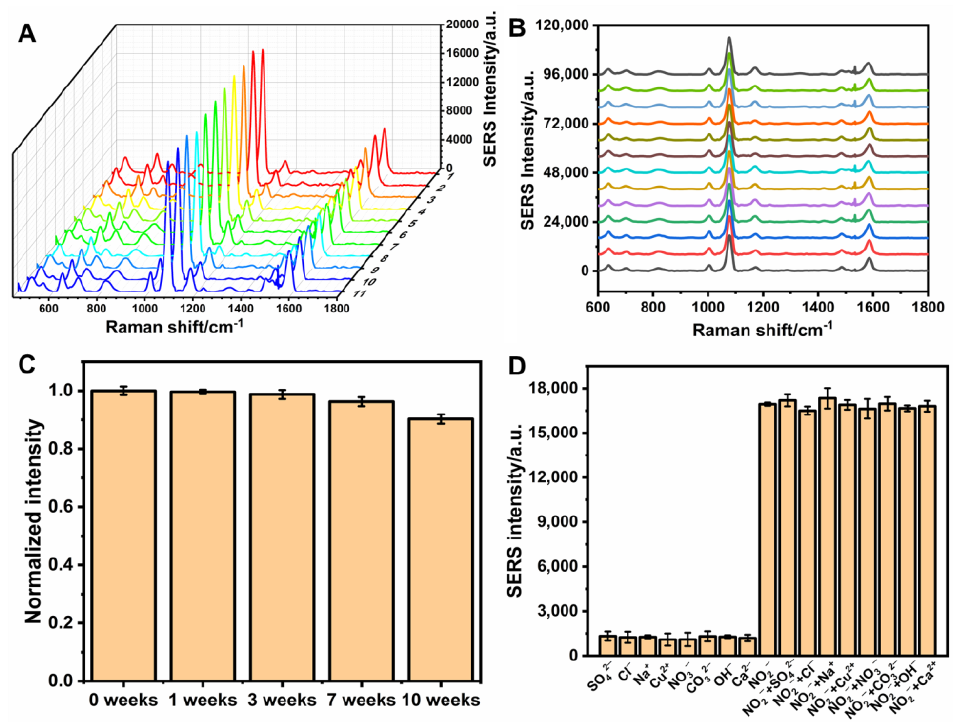
Figure 6. ( A ) Uniformity, ( B ) reproducibility, ( C ) stability, and ( D ) specificity of SERS sensor for the determination of nitrite.